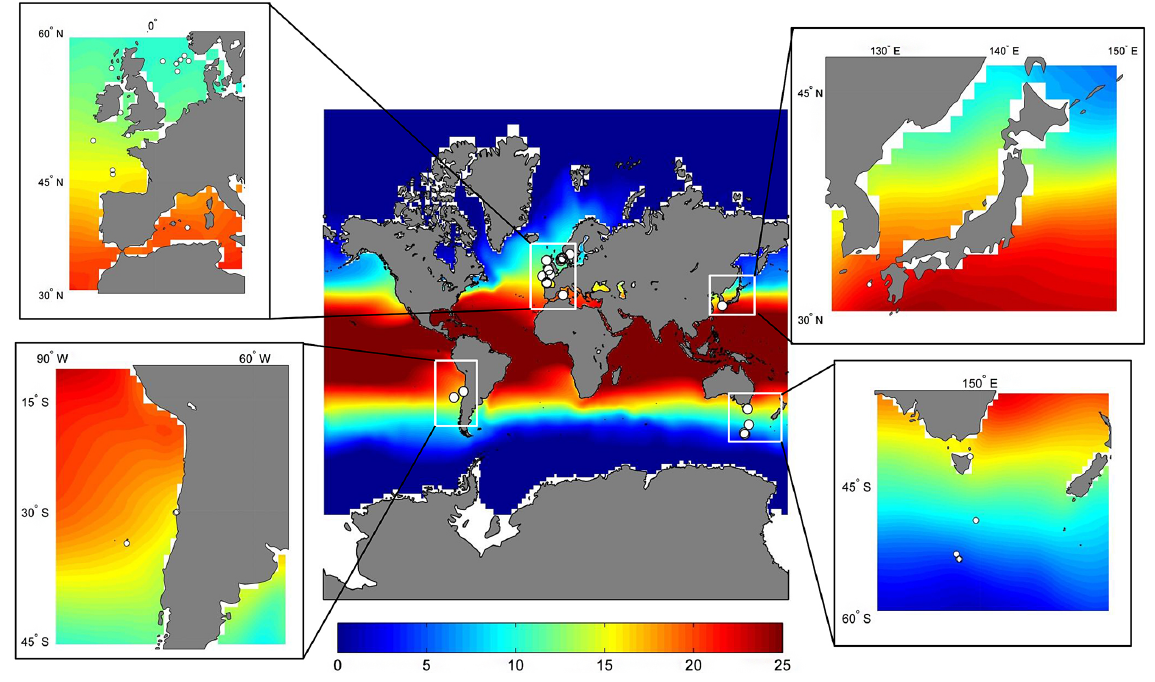
Figure 5. Average sea surface temperature (SST) values for the sampling effort from January 2006 to December 2011 for the world’s oceans. The four regions that include Europe, Japan, Chile and Australia that represent our entire data set are shown in greater detail. Key: temperature colour index from blue to red, 0 to 25 ◦ C,